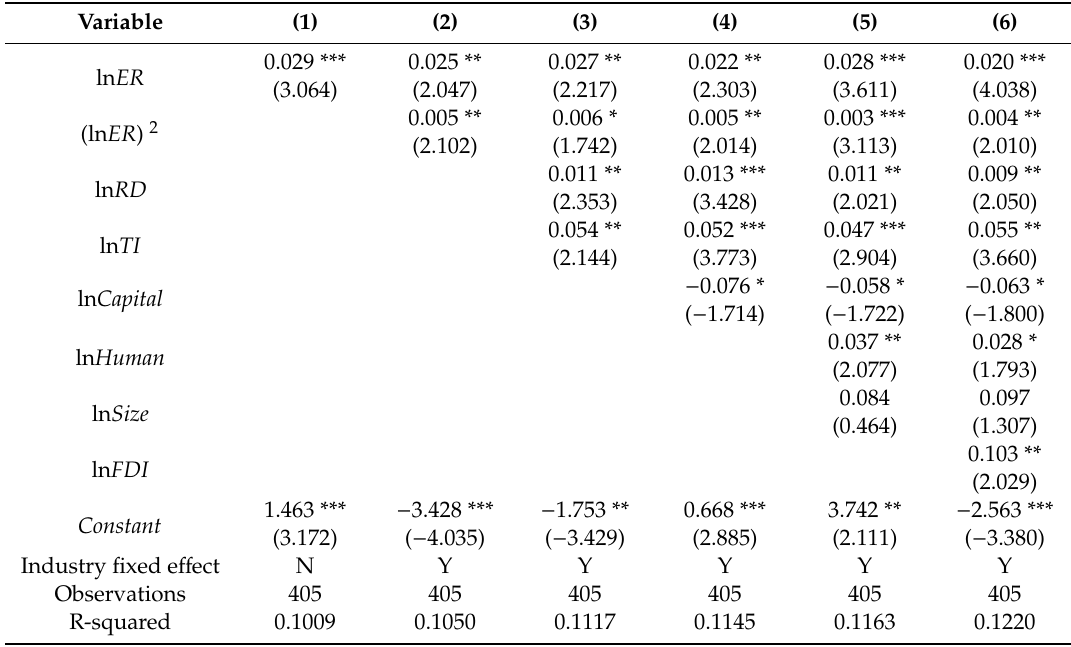
Table 2. Benchmark regression